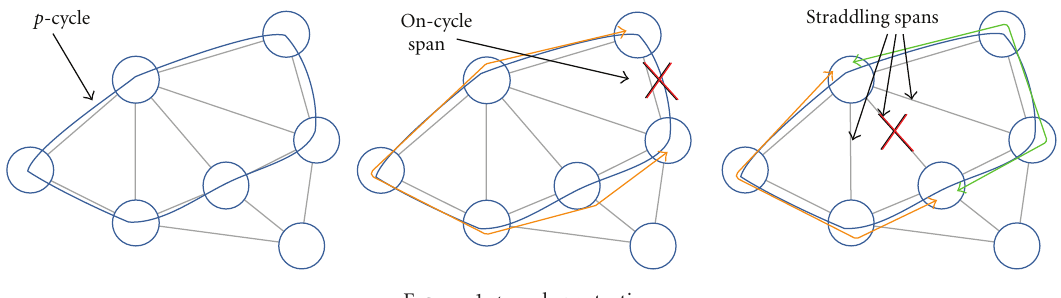
Figure 1: p -cycle